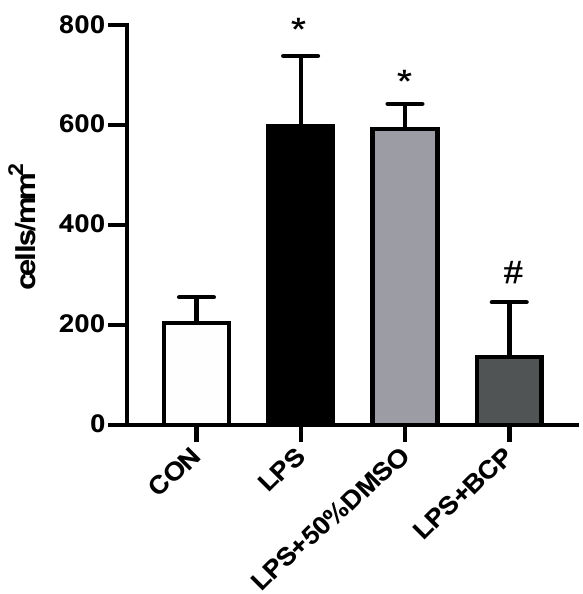
Figure 5. Leukocyte adhesion in submucosal bladder venules of female BALB/c mice for the following experimental groups: control (CON; n = 6), LPS-induced IC (LPS; n = 5), LPS-induced IC treated with 50% DMSO (LPS + 50% DMSO; n = 5), and LPS-induced IC treated with BCP (100 mg/kg, LPS + BCP; n = 6). Saline, LPS, DMSO, and BCP were all administered via intravesical instillation. Data presented as mean ± SD. * p < 0.05 vs. CON. # p < 0.05 vs LPS.